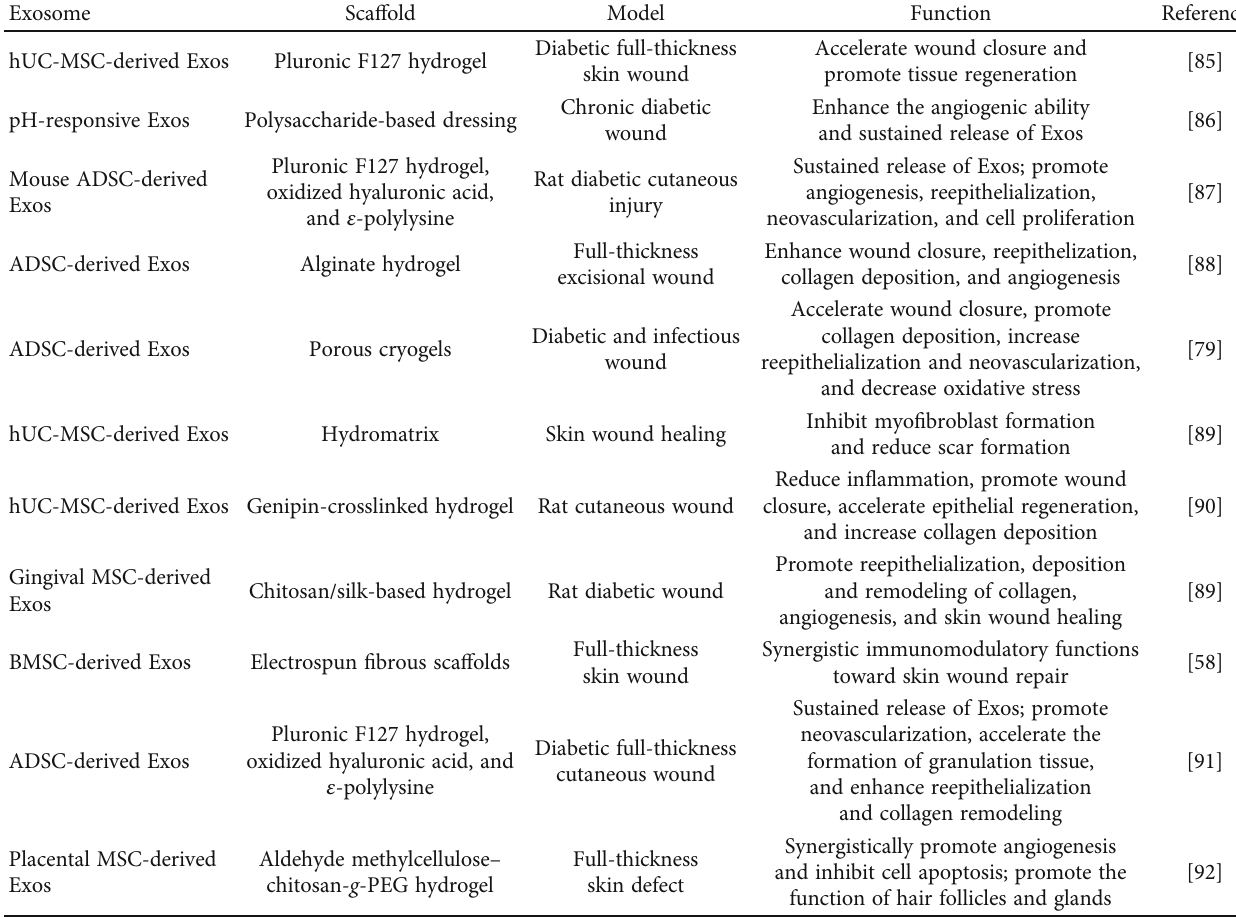
Table 2: Summary of research on immobilized Exos in wound